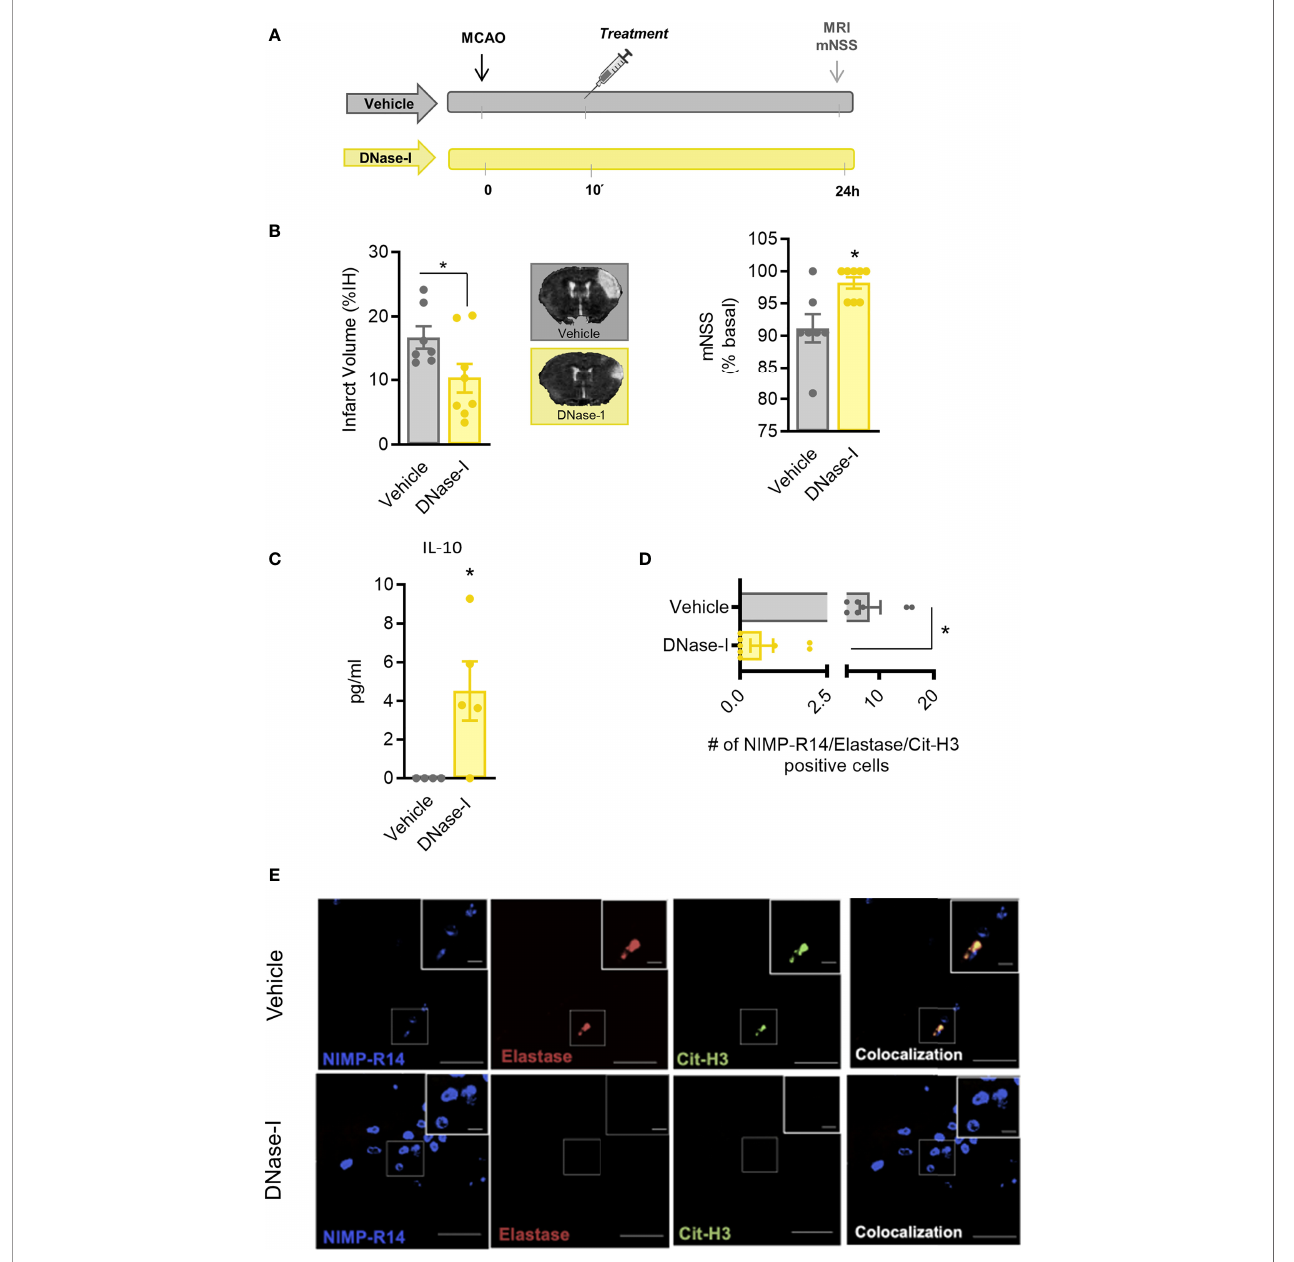
FIGURE 3 | Effect of DNase-I treatment after stroke. (A) Design of the study. (B) Infarct volumes determined 24 hours after the occlusion. (C) Effect of DNase-I on plasma concentration of IL (interleukin)-10 24 hours after the occlusion. (D) Number of NIMP-R14, elastase and Cit-H3-positive cells. (E) Representative images. Data are mean± SEM (n = 4-8 *p < 0.05 vs